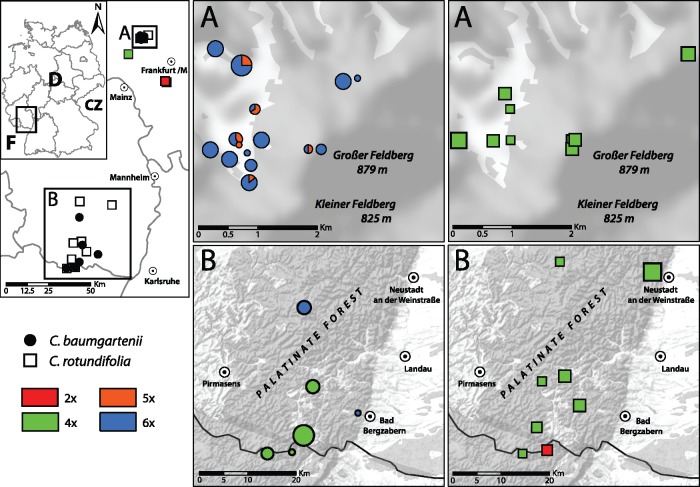
Maps showing the sampling localities of C. baumgartenii (circles) and C. rotundifolia (squares) in the Taunus (A) and Palatinate Forest (B). Color codes differentiate the DNA-ploidy levels and size of symbols is proportional to the number of analyzed samples. Top left is the study area localized within Germany (D, Germany; F, France; CZ, Czech Republic) as well as in more detail within the German states of Hesse (A) and Rheinland-Palatinate (B).